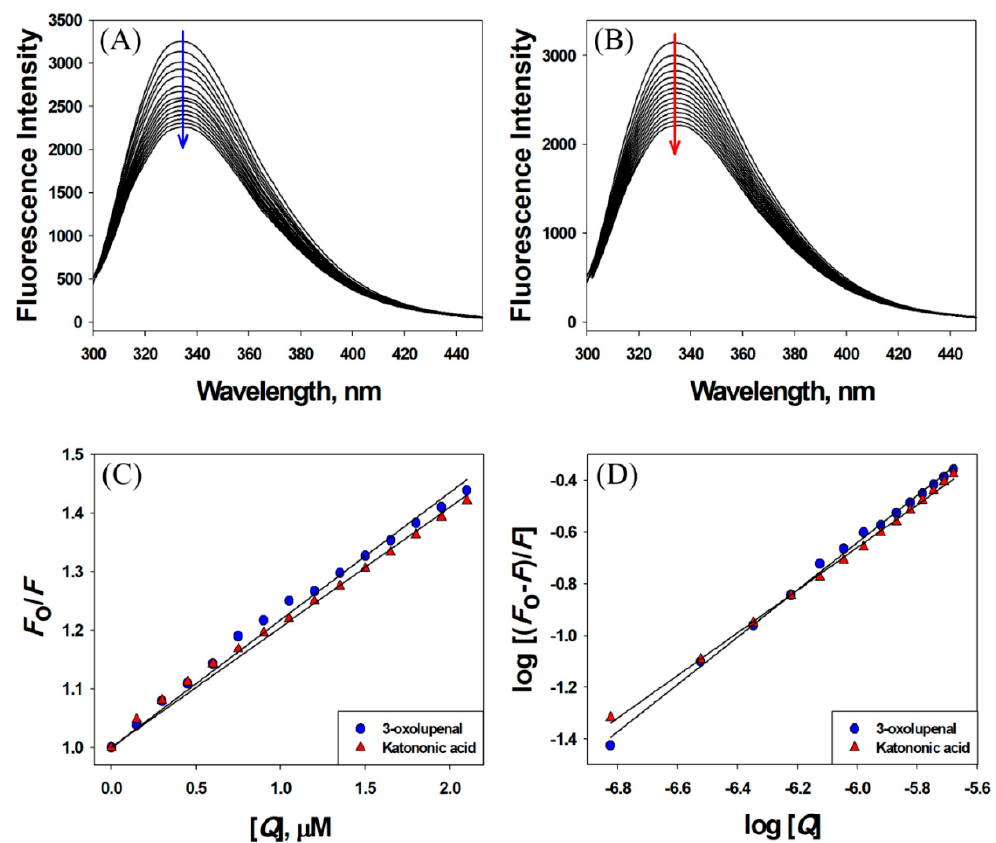
Figure 5. Interaction of α -glucosidase with 3-oxolupenal and katononic acid. Quenching in the fluorescence intensity of α -glucosidase in the presence of ( A ) 3-oxolupenal and ( B ) katononic acid. The binding parameters were deduced from ( C ) Stern–Volmer and ( D ) modified Stern–Volmer plots.